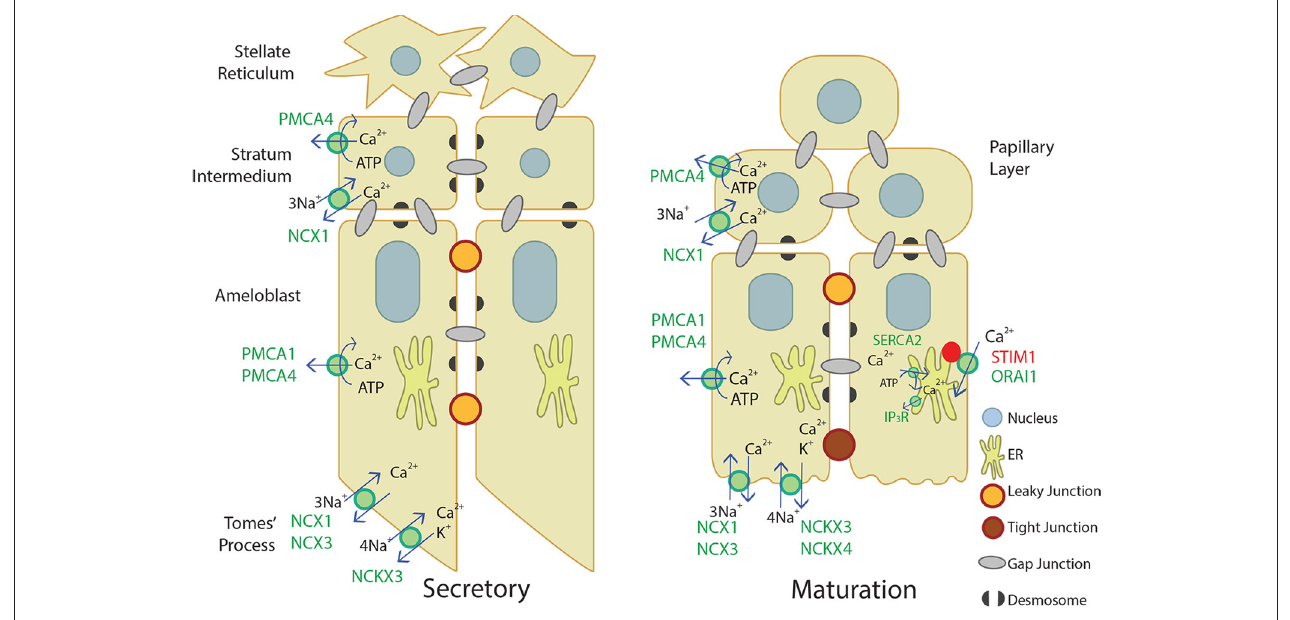
FIGURE 4 | Schematic of what is currently proposed for secretory- and maturation-stage transcellular calcium transport in amelogenesis. During the secretory-stage (left image), active Ca 2 + transport on the lateral membrane is primarily mediated by PMCA1 and PMCA4 and ATP is hydrolyzed in the process. NCX1, NCX3, and NCKX3 mediate Ca 2 + export in the Tomes’ process. More calcium transporters are expressed during the maturation stage (right image). The CRAC channel, composed of the channel ORAI1 and the ER membrane calcium sensor STIM1, mediates the bulk of calcium entry and is active in response to ER calcium store depletion through IP 3 R. The cell then removes calcium from the cytoplasm through the SERCA2 pump that replenishes ER stores, and the NCKX and NCX proteins on the apical border plasma membrane that export calcium into the enamel area and facilitate mineralization (Nurbaeva et al., 2015a,b, 2017). NCX1 and PMCA4 export Ca 2 + from the stratum intermedium (secretory-stage enamel organ) and papillary layer (maturation-stage enamel organ). Desmosomes (Sasaki et al., 1984; Fausser et al., 1998; Jheon et al., 2011 ) and gap junctions (Sasaki and Garant, 1986a,b,d; Pinero et al., 1994; Inai et al., 1997) have also been